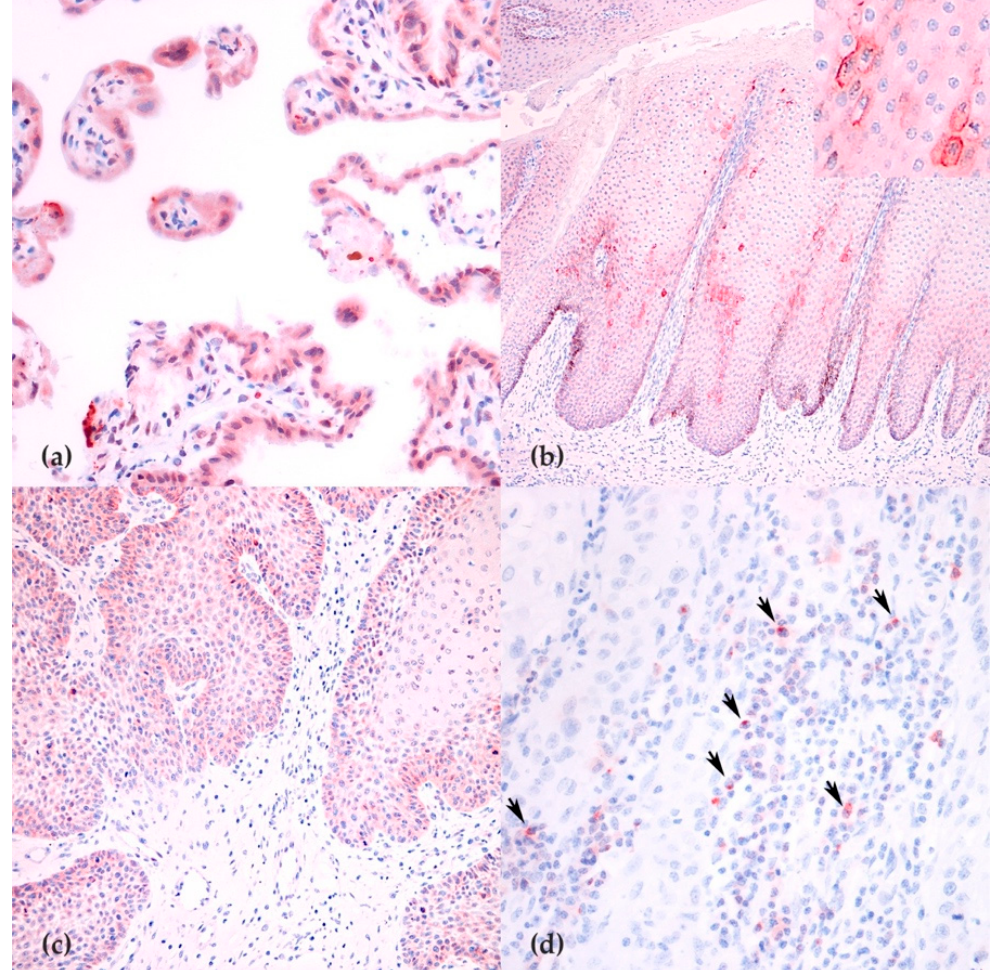
Figure 2. PD-L1 and CTLA-4 expression in equine tissues: ( a ) placental expression of PD-L1 was observed as a cytoplasmic positivity (400×); ( b ) expression of PD-L1 in hyperplastic mucosa near a SCC (100×); ( c ) diffuse expression of PD-L1 in the invasive front of a SCCs (200×); and ( d ) intratumoral lymphocytes expressing CTLA-4 (400×) (arrows).